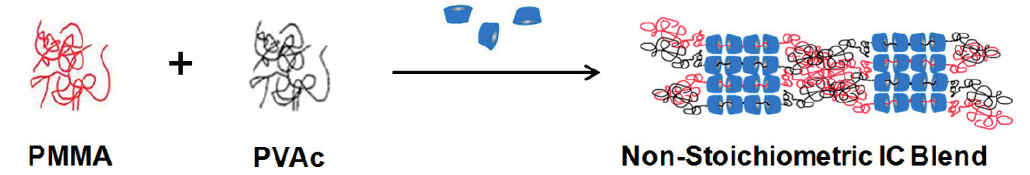
Figure 12. Blending of un-included portions of PMMA and PVAc chains in their common (n-s)- γ -CD-ICs